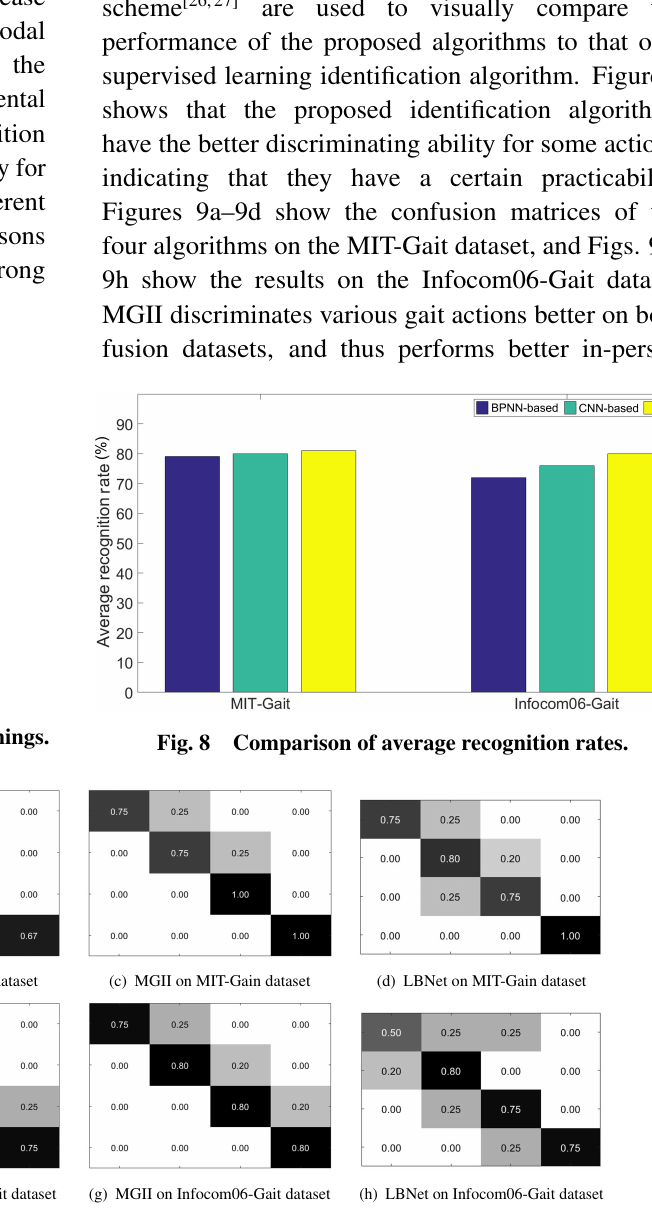
Fig. 9 Confusion matrix comparison of different